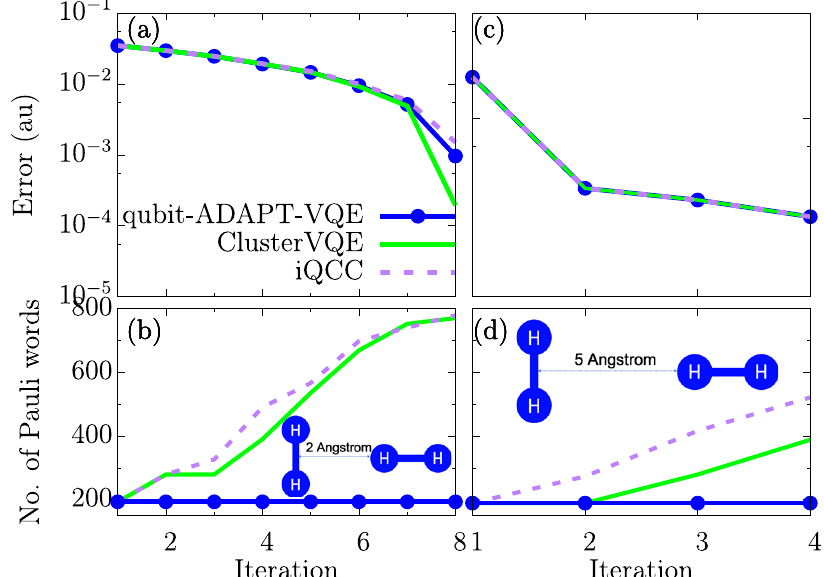
Fig. 3 Simulation of the ð H 2 Þ complex molecule. a , c GS Energy errors and ( b , d ) number of Pauli words per each iteration for the ð H 2 Þ 2 complex molecule obtained from the qubit-ADAPT-VQE (blue), iQCC (purple) and ClusterVQE (green) methods. The intermolecular distances are 2 Å ( a , b ) and 5 Å ( c , d ),